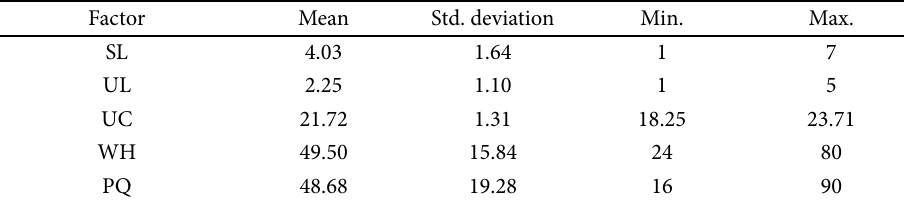
Table 2. Descriptive statistics for the continuous